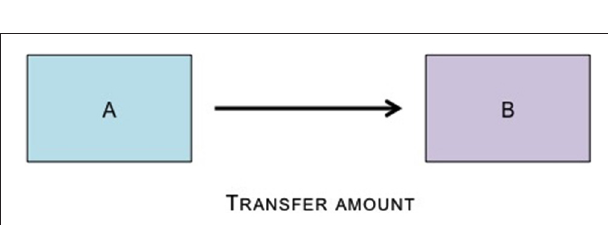
FIGURE 2 | The Dictator Game has two players. One player—the dictator—makes a unilateral decision of how to divide an amount of money with a second player—the